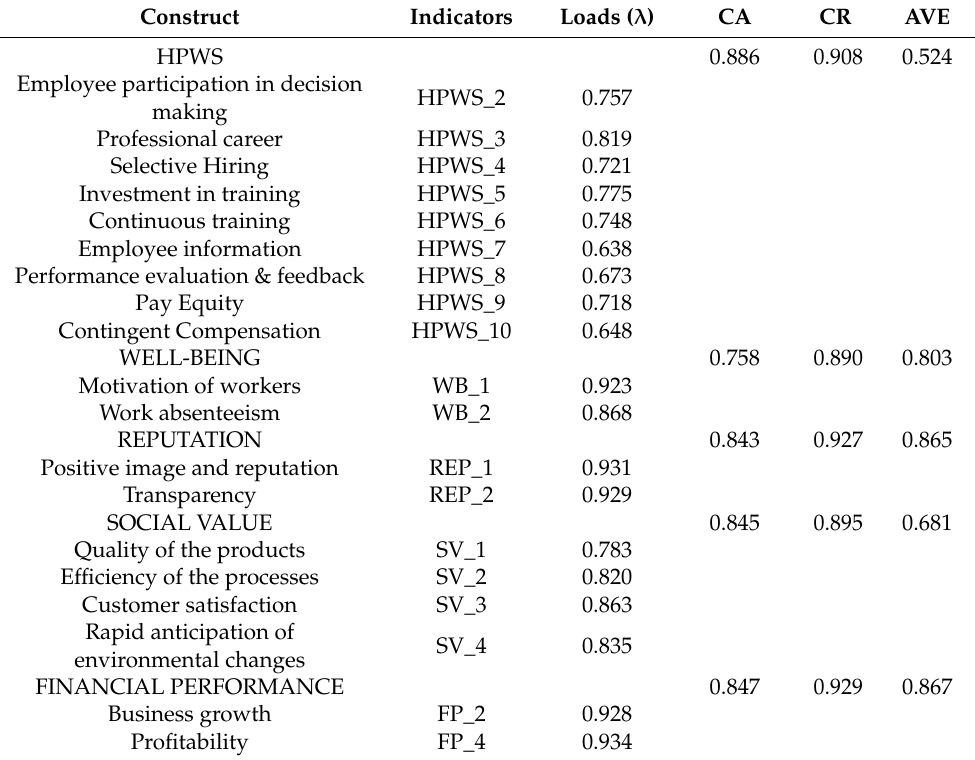
Table 1. Discriminant and convergent validity of constructs. (Source: own based on SmartPLS).